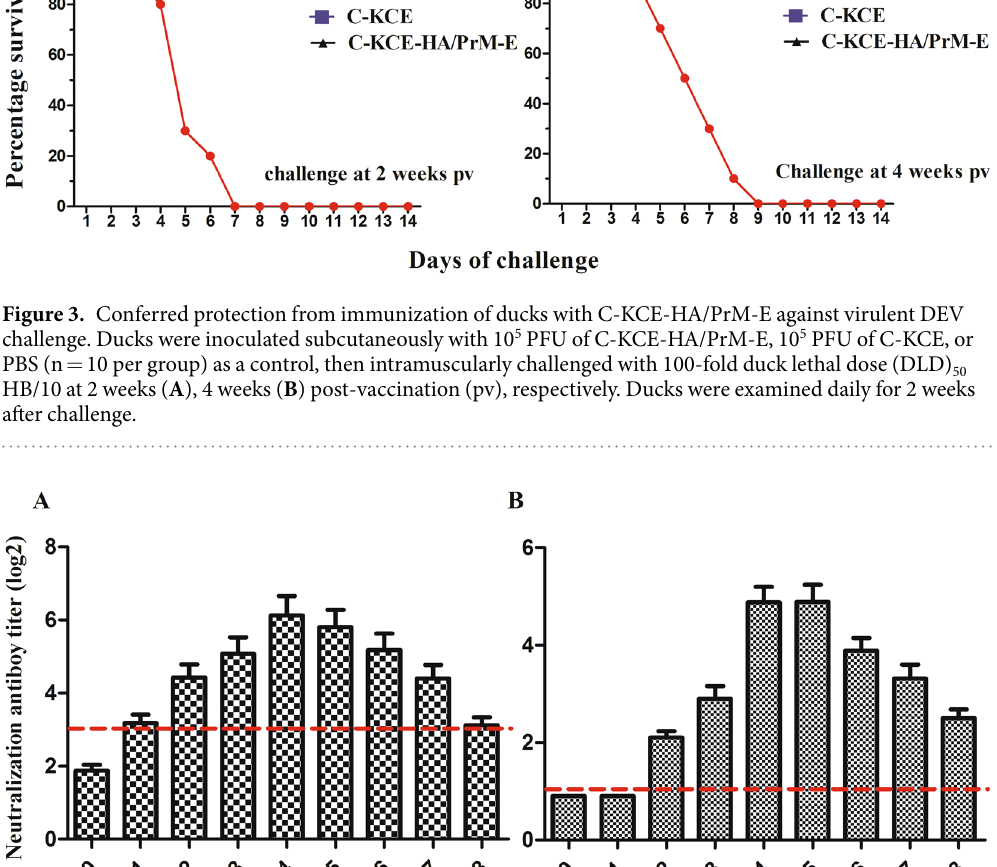
(Fig. 4B). Collectively, these results indicated that ducks vaccinated with C-KCE-HA/PrM-E could elicit humoral immune responses against XN/07 and df2 simultaneously. Cellular Response to C-KCE-HA/PrM-E Viral Vaccination. To determine the serum levels of Th1-type cytokines and Th2-type cytokines, serum levels of IFN- γ and IL-4 were analyzed. As expected, markedly higher levels of IFN- γ and IL-4 were detected in the C-KCE-HA/PrM-E-receiving group compared to the C-KCE and PBS groups (Fig. 5). Cellular immune response was further evaluated by determining the ability of duck peripheral mononuclear cells to show a proliferative response against purified HA or E protein. As shown in Fig. 6, a significantly enhanced T-cell proliferative response to HA or E protein was clearly observed in the groups immunized with C-KCE-HA/ PrM-E when stimulated with purified HA or E protein, whereas the ducks vaccinated with C-KCE or PBS buffer did not respond to the purified HA or E protein. Ducks in all groups responded similarly to stimulation with pos- itive control ConA. These results indicate that C-KCE-HA/PrM-E can elicit cellular immune response in ducks. Vaccine efficacy against pathogenic H5N1 and DTMUV isolates challenge in ducks. Given that humoral immune response could be elicited by C-KCE-HA/PrM-E, we next asked whether C-KCE-HA/PrM-E would confer protection against H5N1 and DTMUV challenge. Specifically, the efficacy of C-KCE-HA/PrM-E as a candidate vaccine was evaluated by exposing ducks to H5N1 and DTMUV after vaccination with C-KCE-HA/ PrM-E.